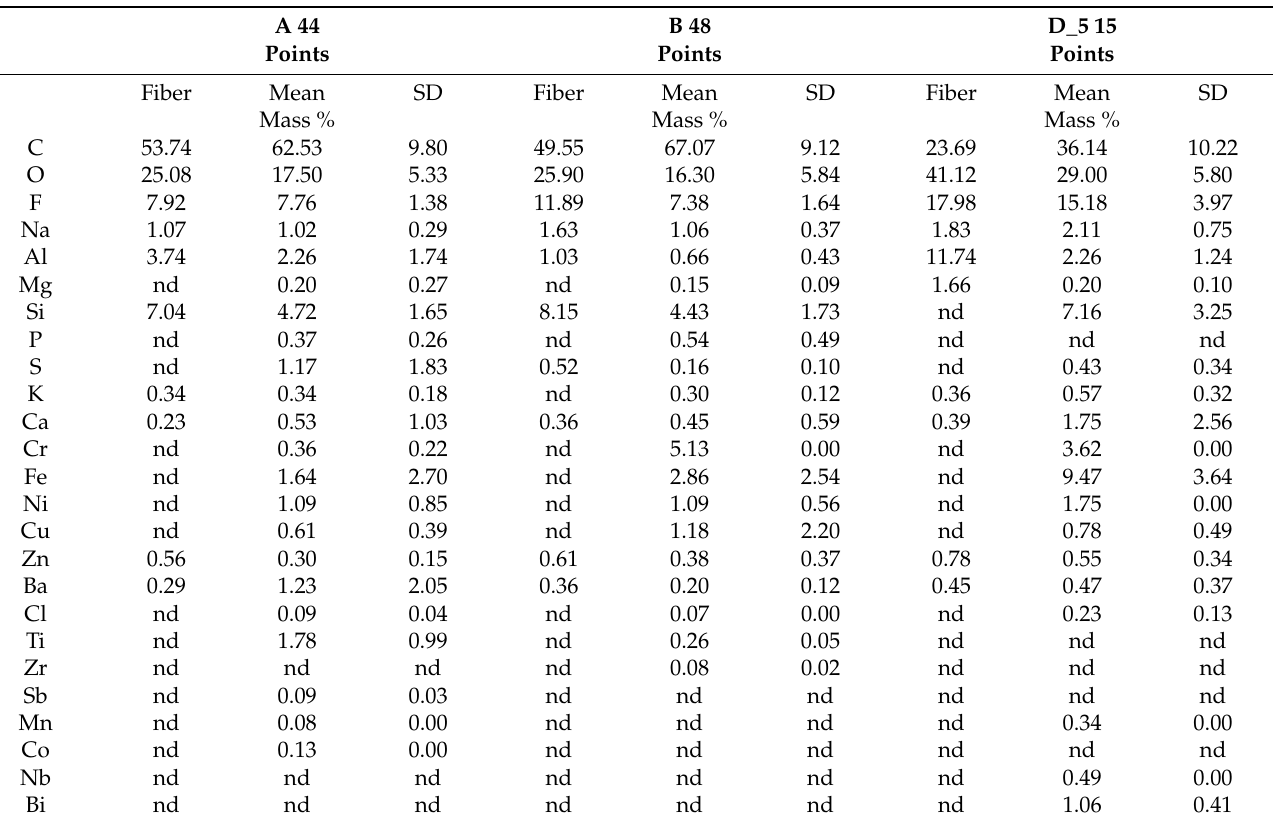
Table 10. The mean concentration of the studied elements from the groups A, B, and D_5. The results include the measurement of a fiber from each group. The mean concentration and standard deviation of the elements in the solid particles are based on the results of numerous analysis